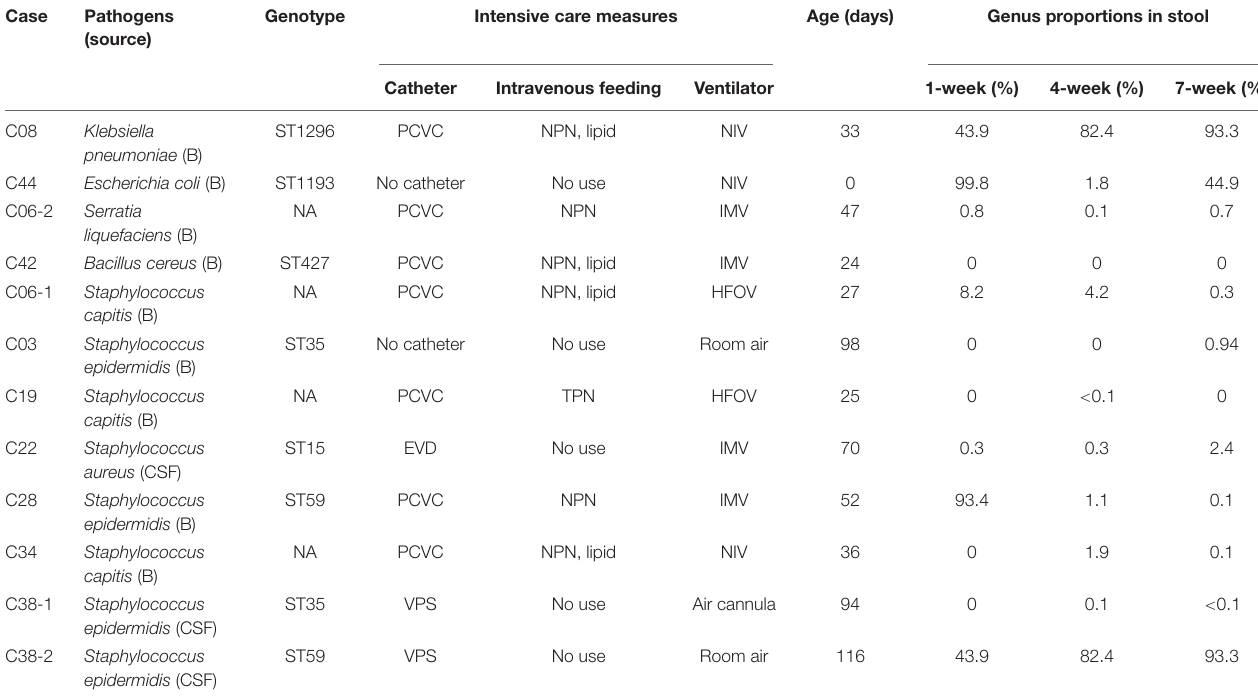
TABLE 2 | Bacterial pathogens causing 12 episodes of neonatal sepsis in 10 preterm infants, the intensive care measures used, and the proportions of bacterial genus identical to the causative pathogens in gut microbiota.